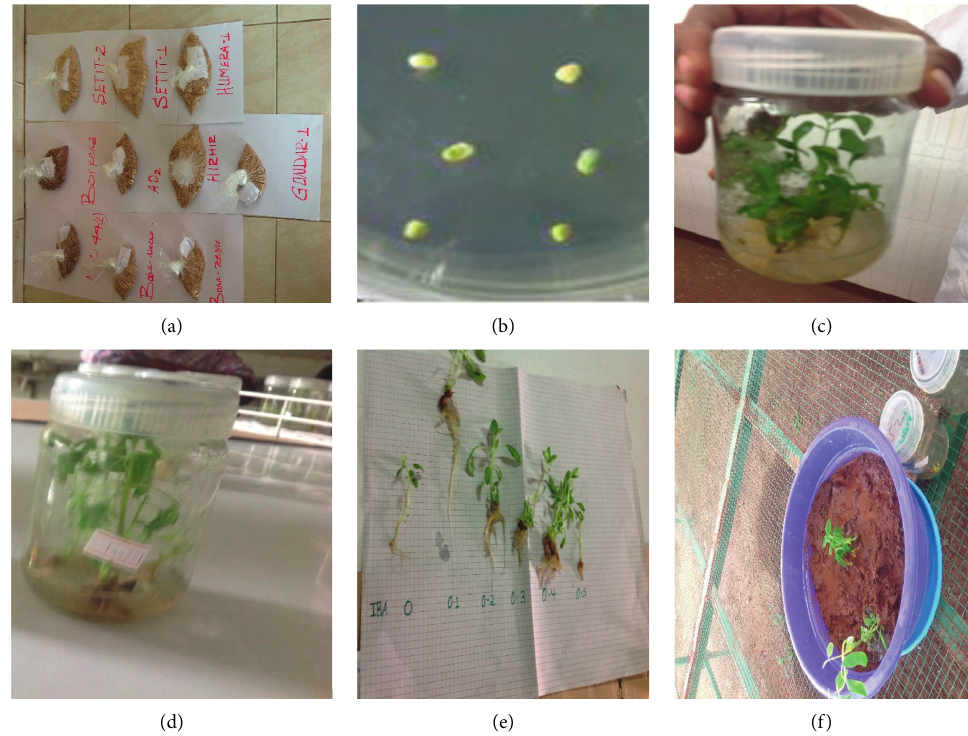
Figure 1: In vitro shoot regeneration in Sesamum indicum genotypes. (a) Seeds of sesame genotypes collected from HuARC. (b) Cotyledon explants after 7days of culture. (c) Best regeneration of Hirhir genotypes from cotyledon explant. (d) Best shoot number in Aberghele genotype. (e) An in vitro plantlet showing the well-developed root system and make ready for acclimatization. (f) Well-rooted plantlets transferred to soil to